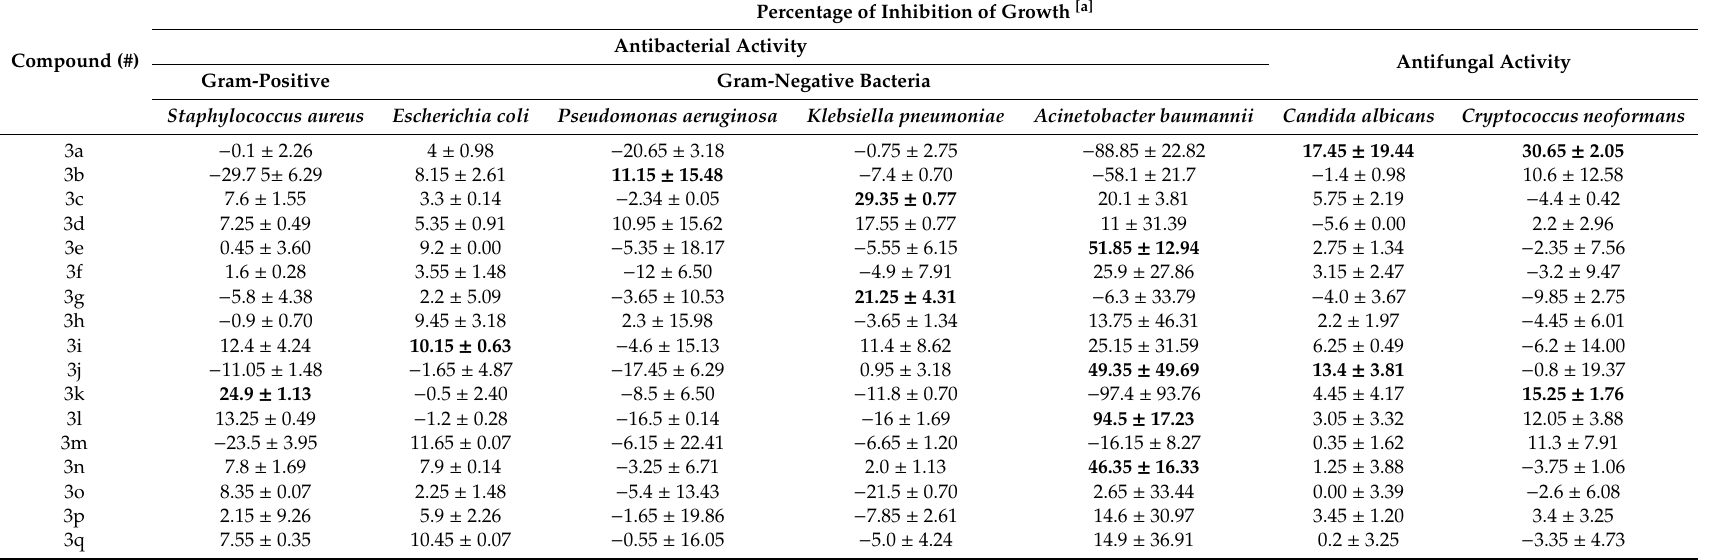
Table 1. Antimicrobial activity of compounds ( 3a – q ) with the concentration set at 32 µ g / mL in